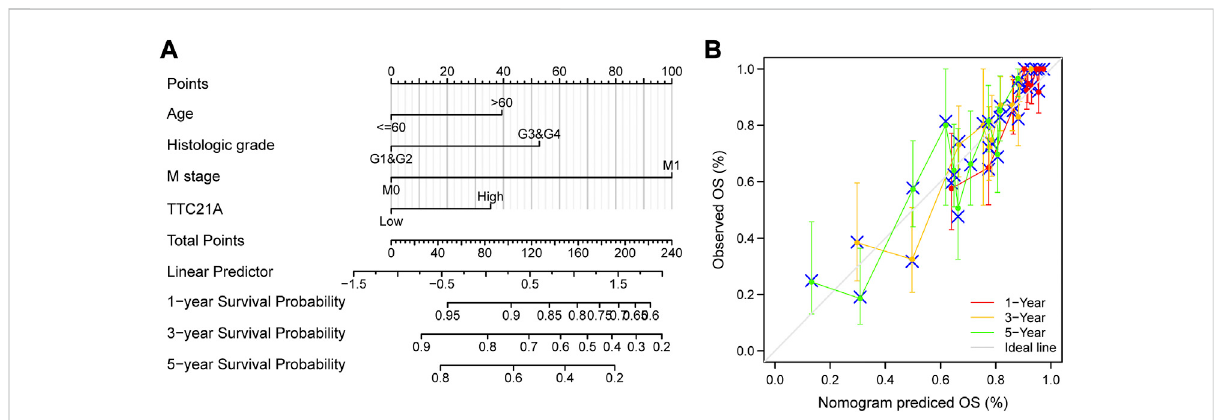
FIGURE 4 Predictive ability of TTC21A in ccRCC. (A) Nomogram for predicting overall survival of ccRCC. (B) Calibration curve of the